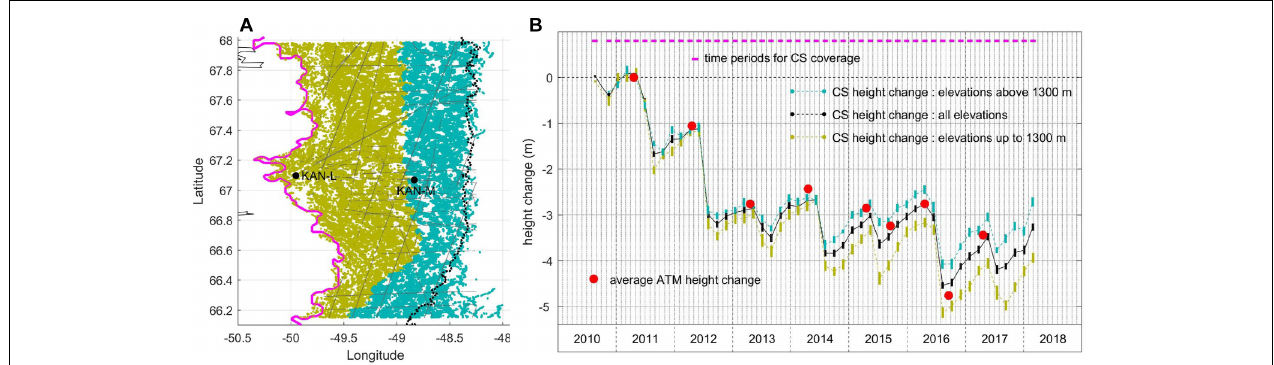
FIGURE 2 | (A) Positions of the CryoSat height estimates for two elevation ranges, above (87,000 samples in light blue) and below 1300 m (79,500 samples in fawn), and of two of the PROMICE KAN weather stations. The solid magenta line indicates the ice sheet edge and the dotted black line is the 1500 m contour. IceBridge laser terrain mapper (ATM) data were collected in this area in the springs of 2011 to 2017 and in the falls of 2015 and 2016, and their positions are shown by the gray dots. (B) Temporal height change with respect to the winter 2011 for all the data (black), data < 1300 m (fawn) and data > 1300 m (light blue). The data was binned in intervals of 60-days, the actual time periods are shown as the sequence of short magenta lines at the top of B . The red dots illustrate the ATM height change averaged over the same geographic area and referenced to the spring of